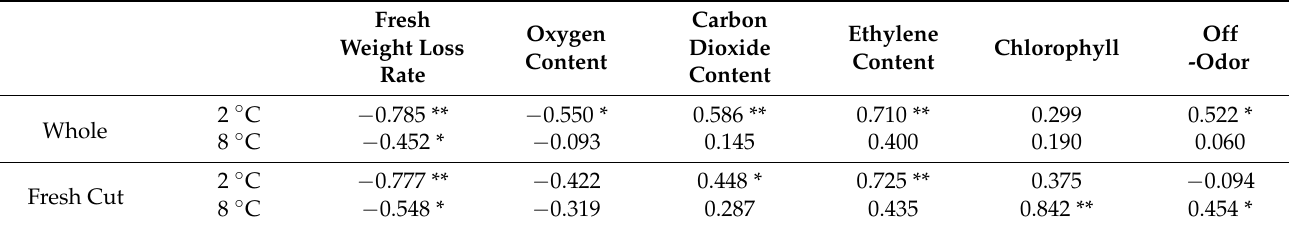
Table 4. The values for the Pearson’s correlation between the overall quality and characteristics of romaine lettuce for different types and at different storage